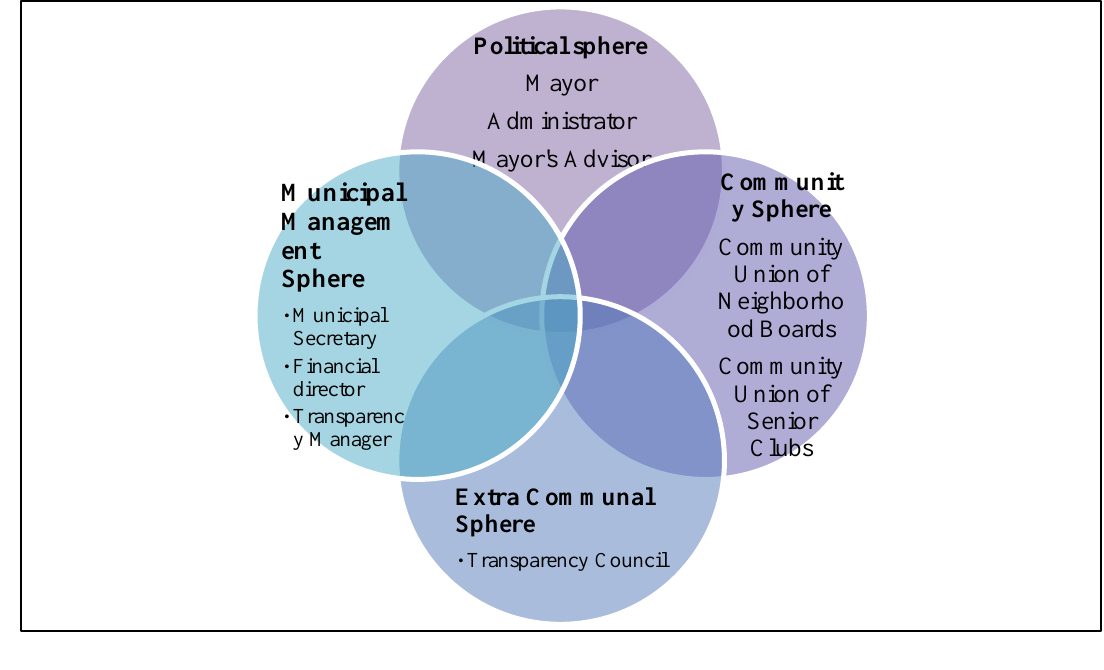
Figure 1: GAM Analysis Spheres in Calle Larga (source: